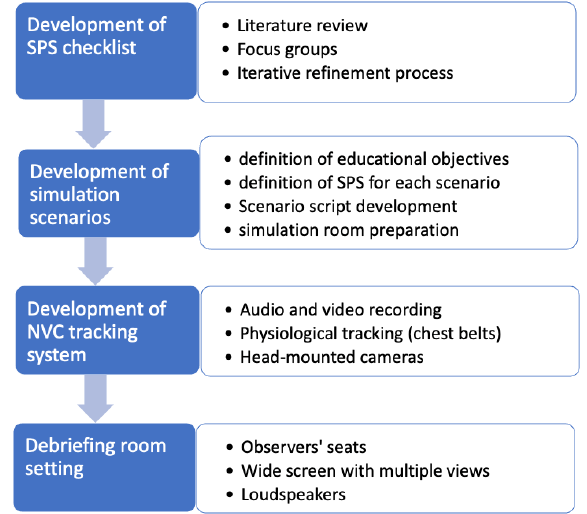
Figure 1. Outline of the preparation of materials.